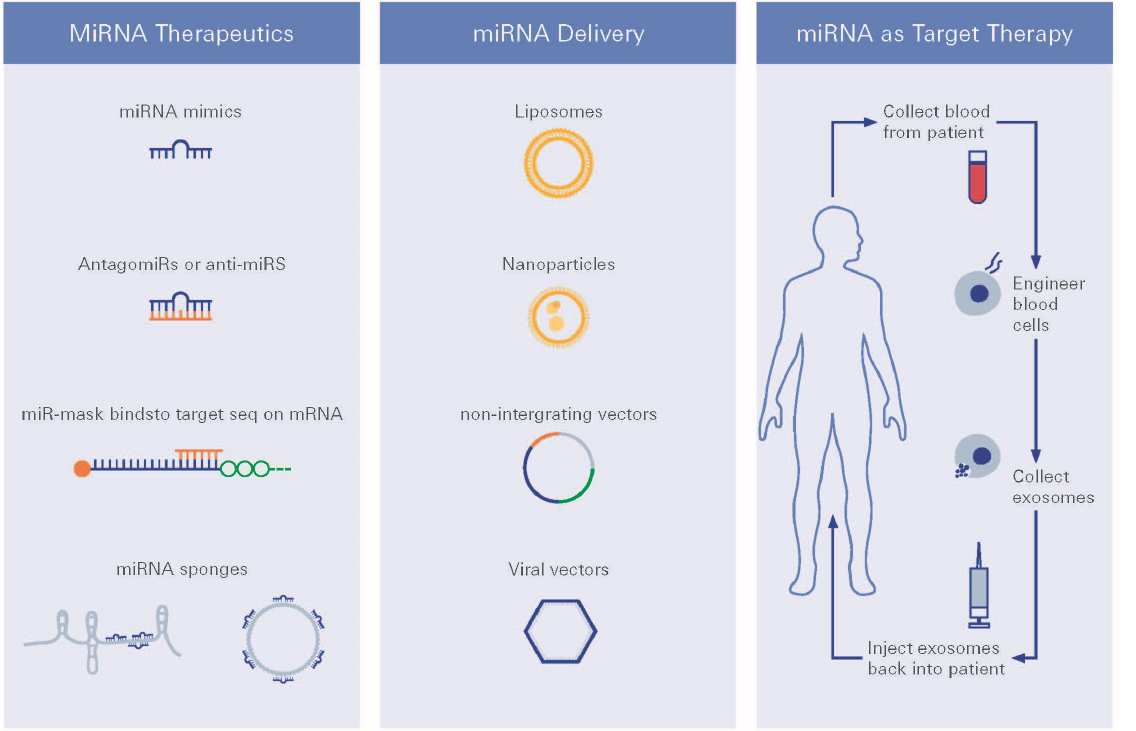
Figure 6. miRNA therapeutic strategies. Different strategies for miRNA targeted therapy, i.e., choice of delivery vehicles and route of delivery are being presented.